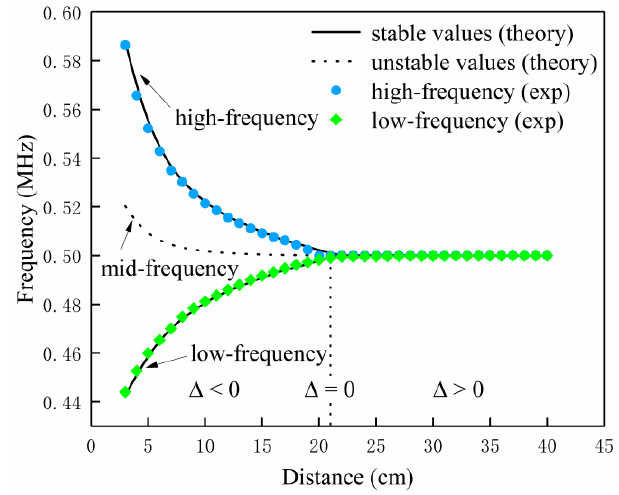
Figure 3. Operating frequency versus distance between the Tx and Rx coils at complete matching.